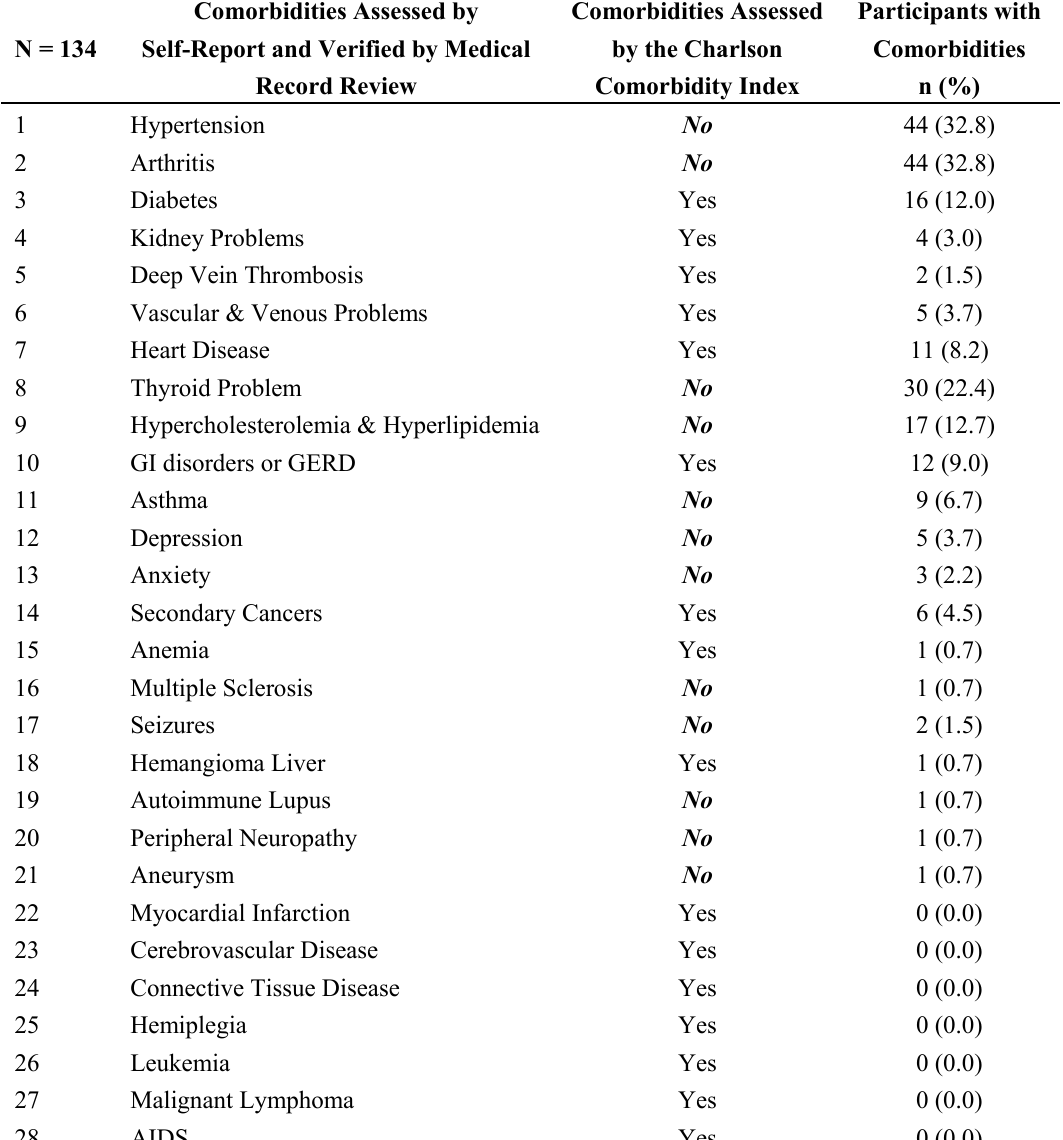
Table 2. Comorbidities: Self-Report Verified by Medical Record